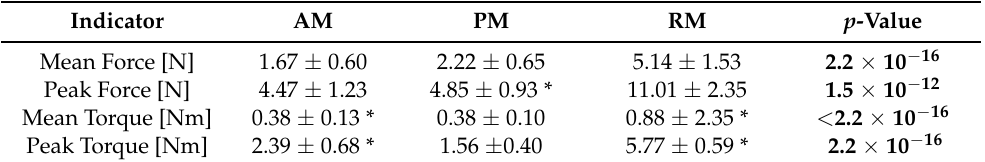
Table 3. Summary of physical interaction data between users and the AGoRA Smart Walker under several assistance modes.